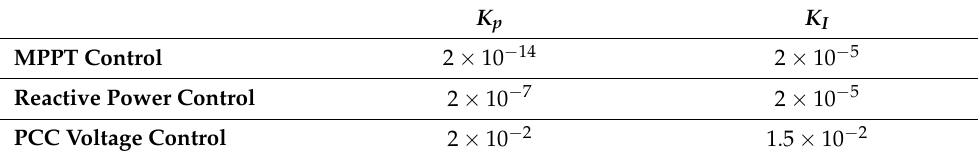
Table A3. PI controller